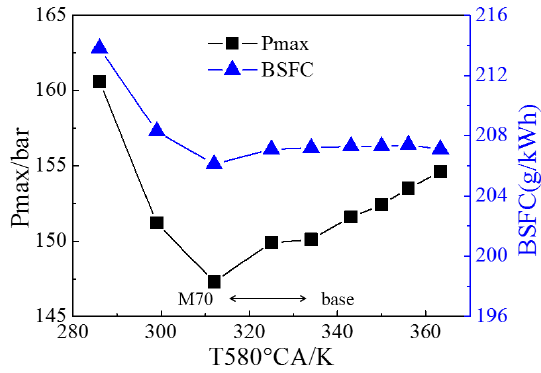
Figure 12. Influence of Miller timing on firing pressure and BSFC (brake specific fuel